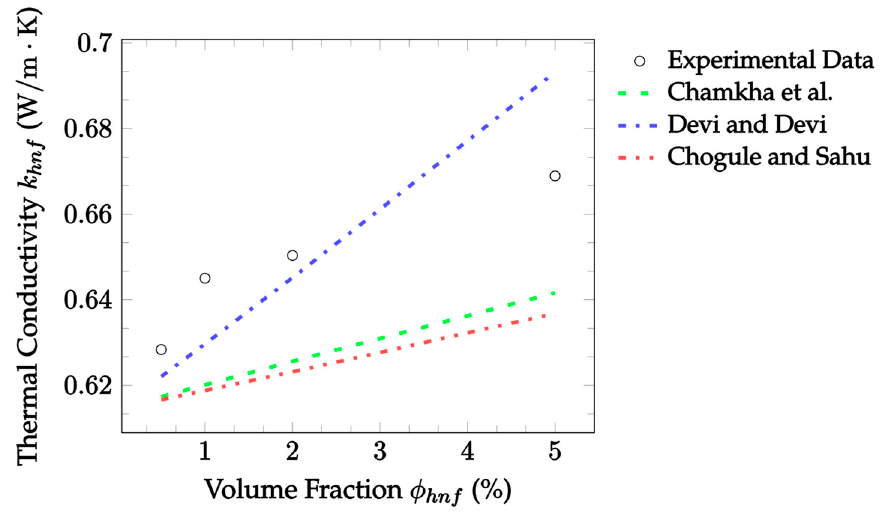
Figure 14. Experimental findings for 10:1 TiO 2 –Ag/Water hybrid nanofluid compared with more theoretical predictions: Experimental Data [88], Chamkha et al. [37], Devi and Devi [38], Chougule and Sahu [39].